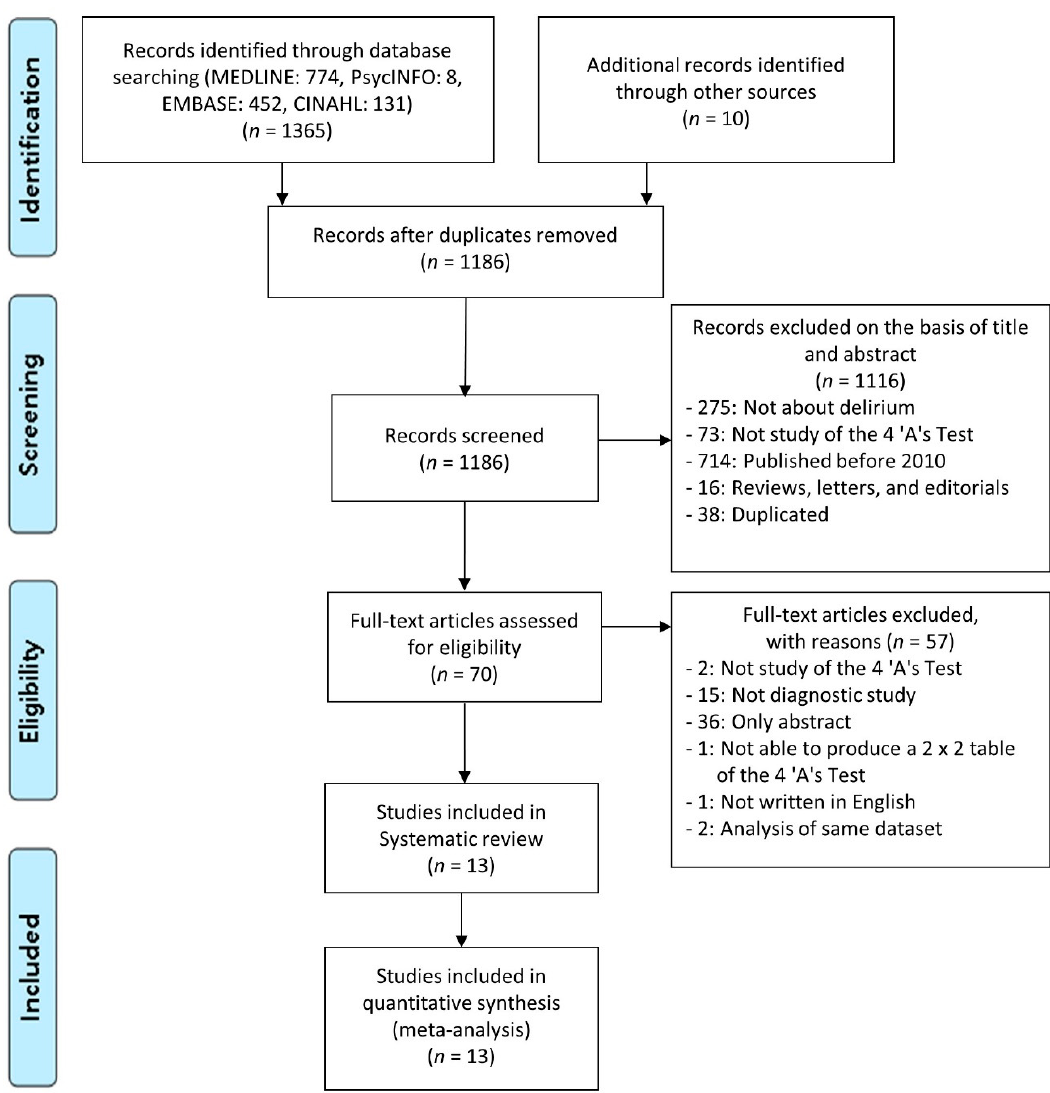
Figure 1. The flow chart of the search for eligible studies.